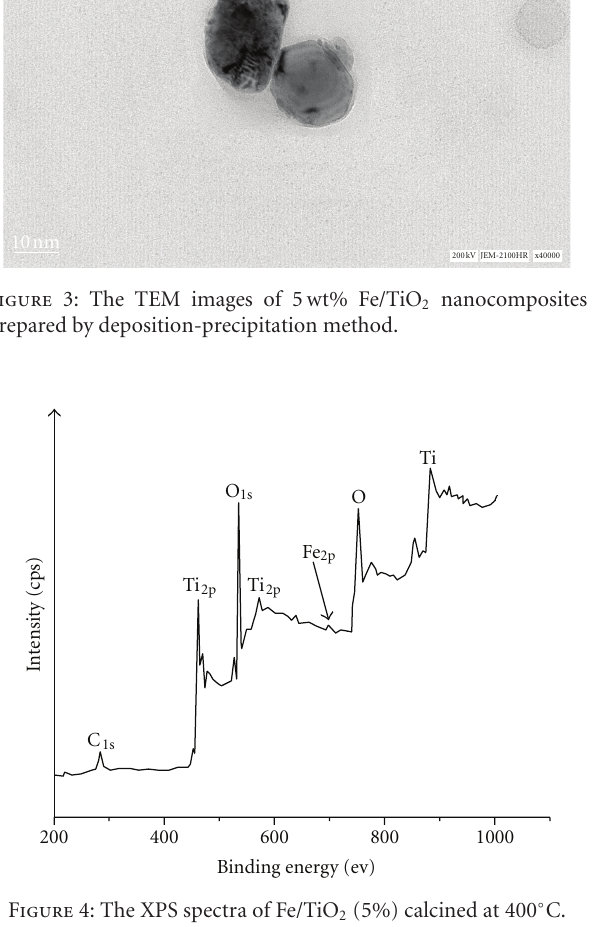
Fe over the surface of TiO 2 is 4.68 wt%, which is basically consistent with the theoretical expectation.